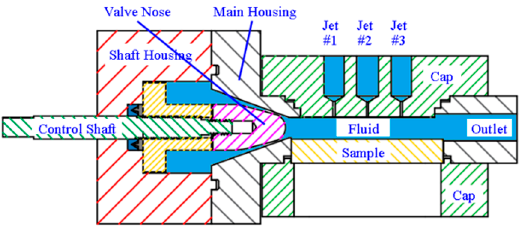
Figure 5. Cutaway of the cavitation device.